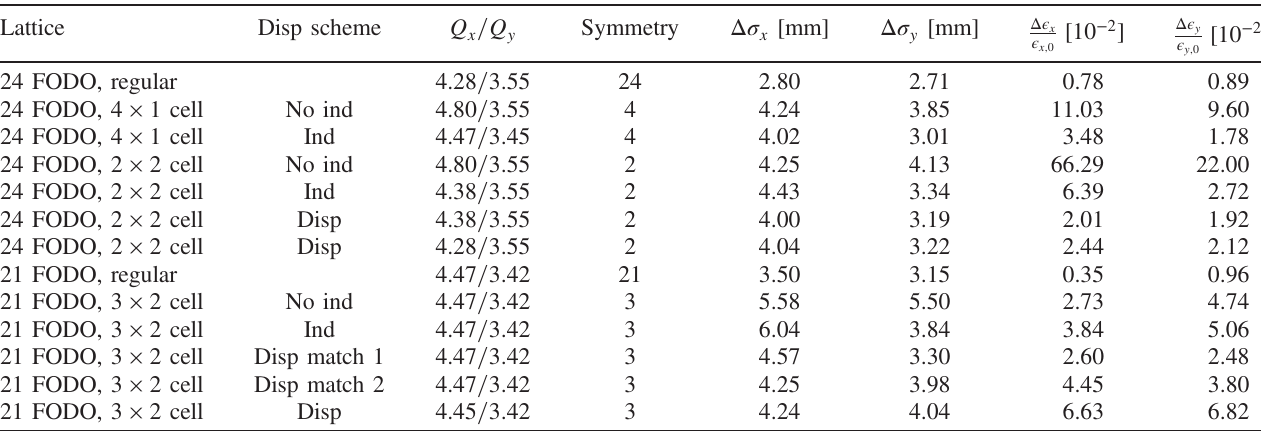
TABLE XI. Deviation of the beam size Δ σ z as defined in Eq. (13) and relative emittance growth for the 24-cell FODO lattice with and without straight sections and the 21-cell FODO lattice with and without straight sections. Scheme A without individual quadrupoles is abbreviated by no ind, scheme A with individual quadrupoles by no ind and scheme B with disp in agreement with the labeling in Fig.